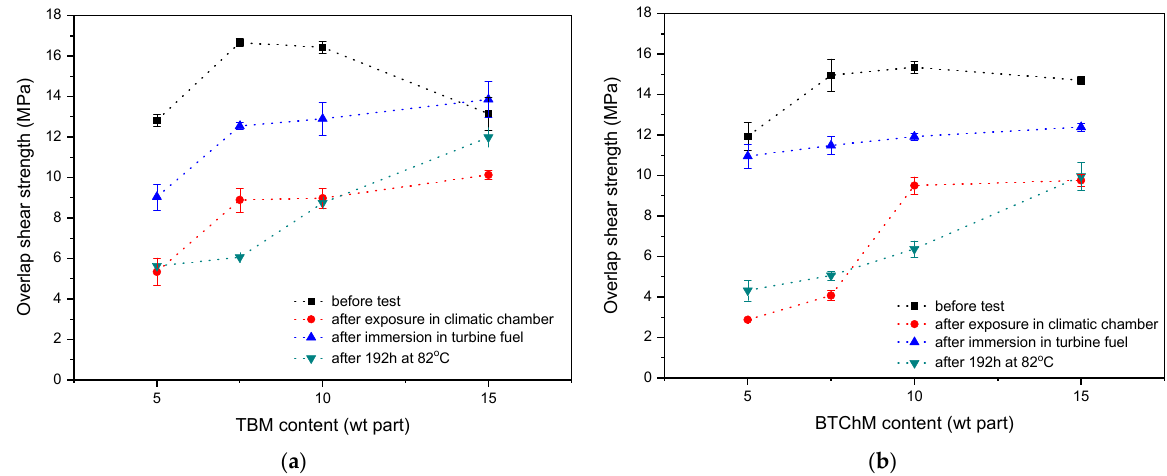
Figure 7. Overlap shear strength (before and after aging tests) of Al/SAT/Al joints based on MAT-T ( a ) and MAT-B ( b ). In detail, higher telogen concentrations (up to 10 wt. parts) increased the τ values: from 12.8 MPa (SAT-T-5) to 16.4 MPa (SAT-T-10) and from 11.9 MPa (SAT-B-5) to 15.3